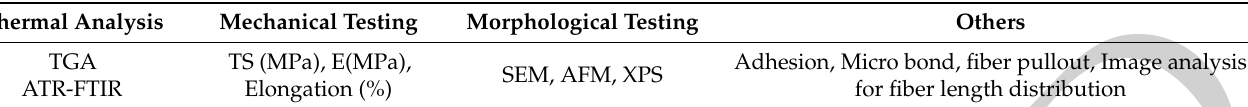
Table 2. Characterization methods used in CFRC/GFRC recycling processes [40].